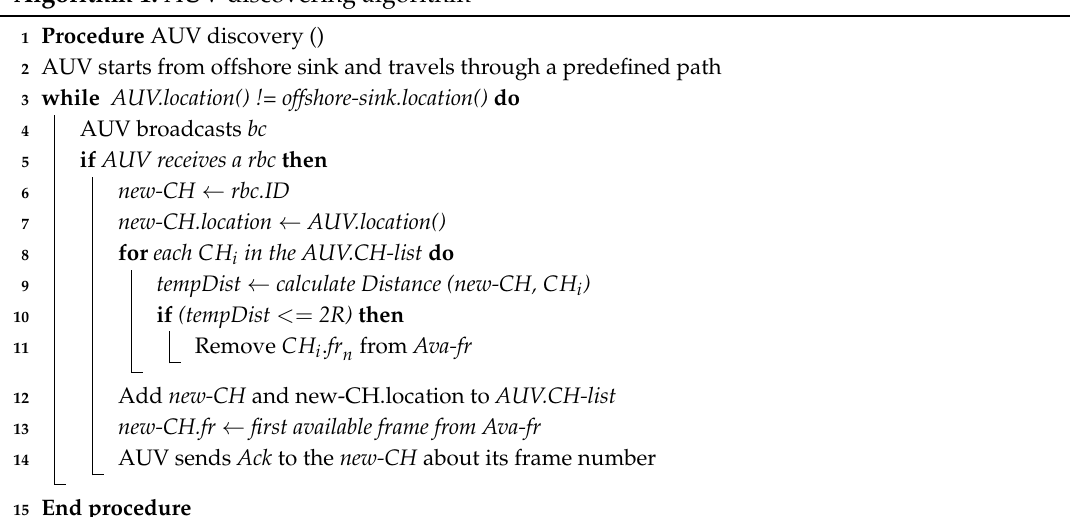
Algorithm 1: AUV discovering